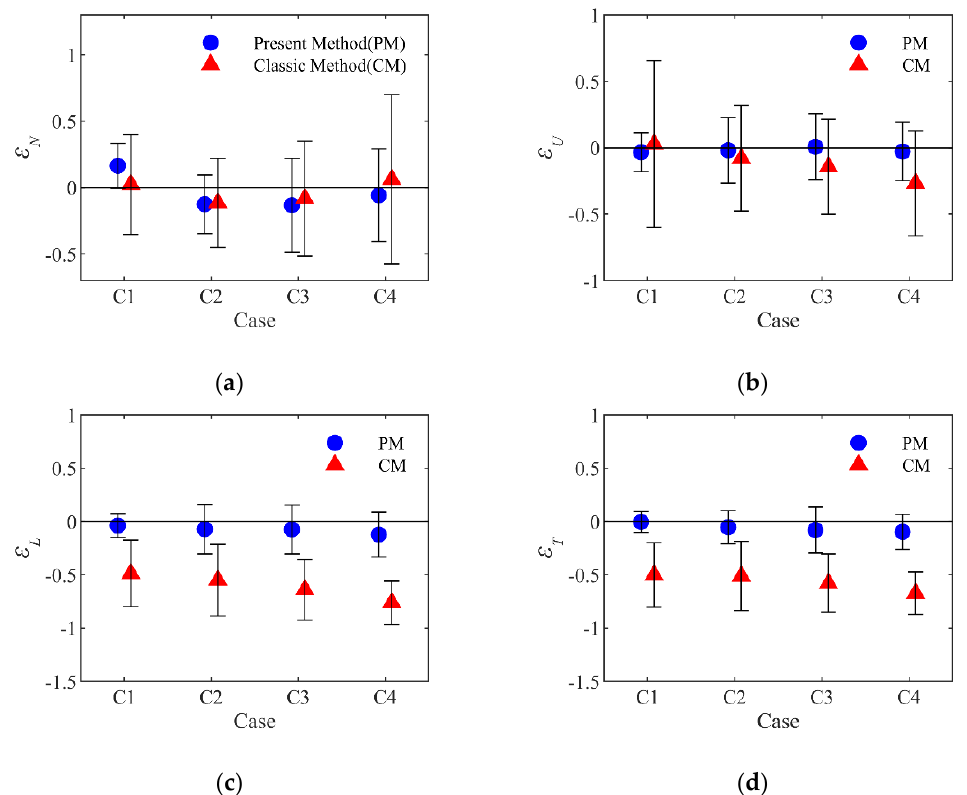
Figure 9. The mean and standard deviation relative error of N , U , L and T , shown in ( a – d ) in separate. PM and CM indicated as blue point and red triangle which represent present and classic methods, respectively. The error bars are the standard deviation of relative error.